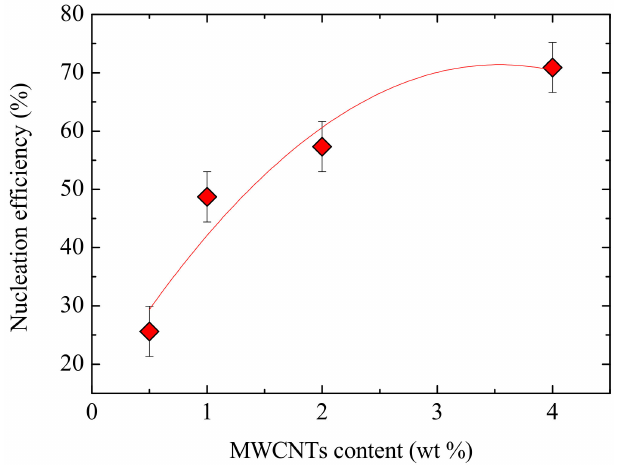
Figure 16. Nucleation efficiency as a function of MWCNT content. The experimental points are fitted with a polynomial fit to guide the